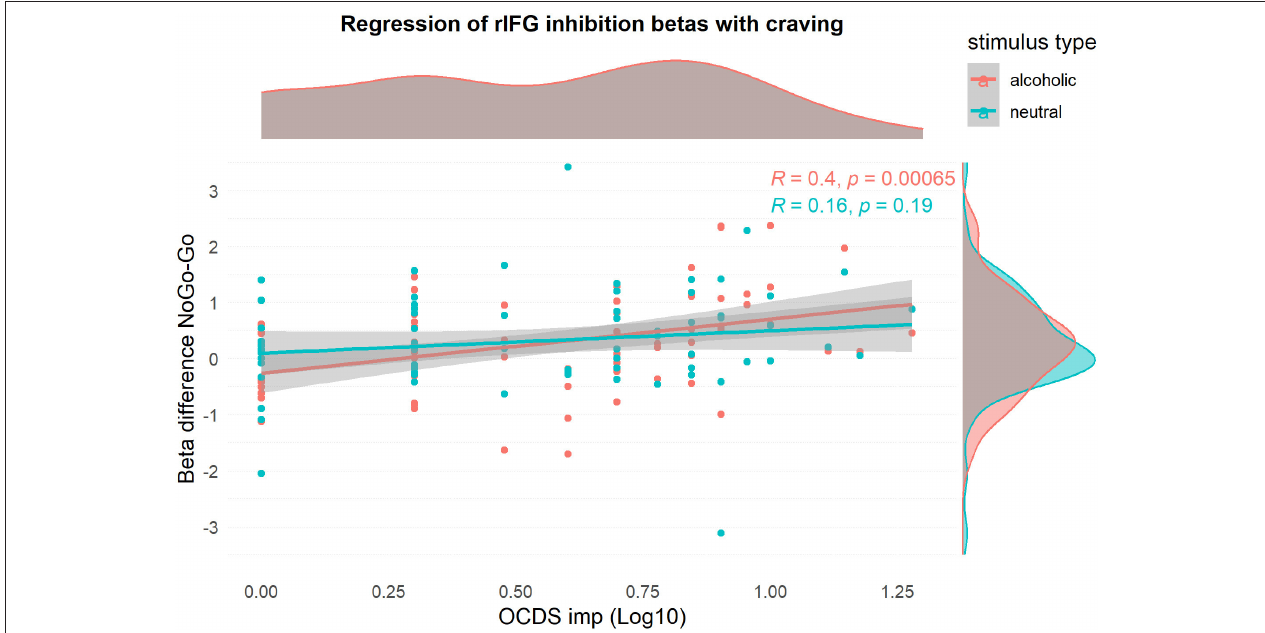
FIGURE 3 | Visualization of the relationship of rIFG beta-values and log10-transformed OCDSimp scores, stratified for stimulus type. The graph confirms that craving has a positive relationship with inhibition activation during alcohol-related inhibition only.